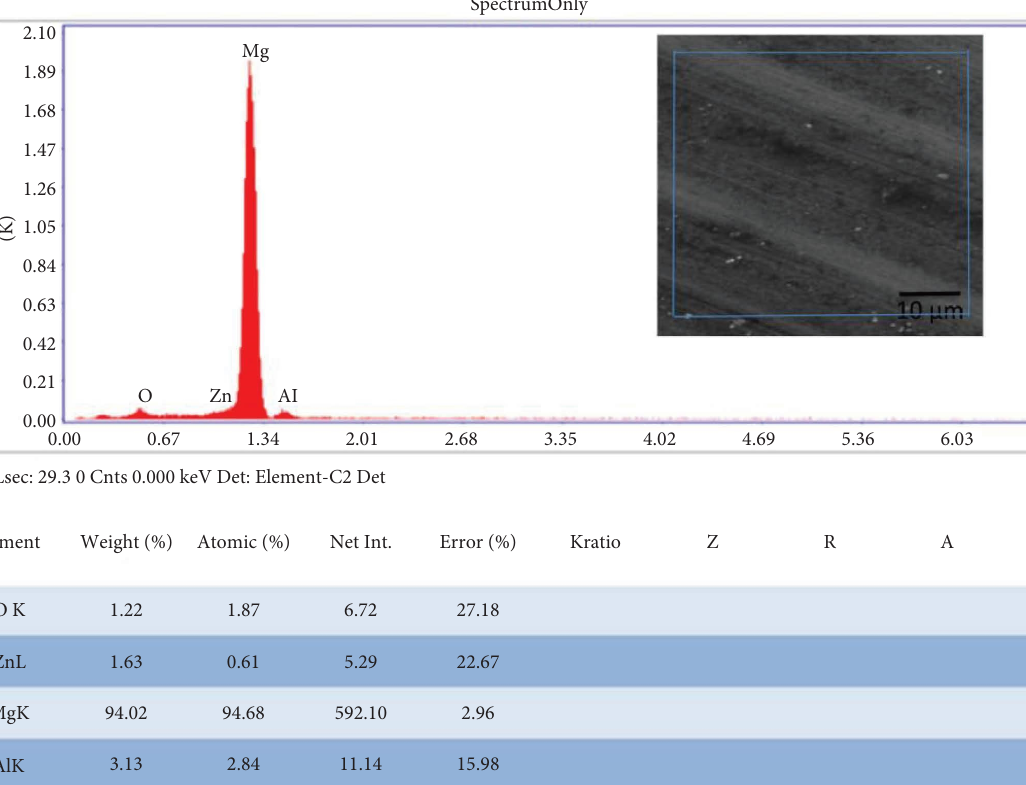
Figure 4: EDS analysis of AZ31